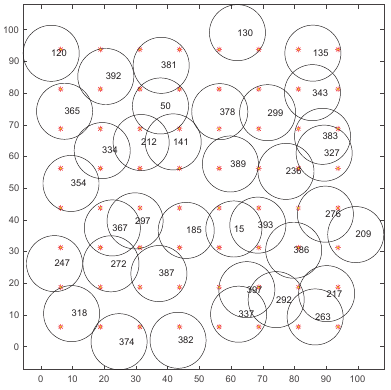
Figure 9. The coverage diagram after the 15th